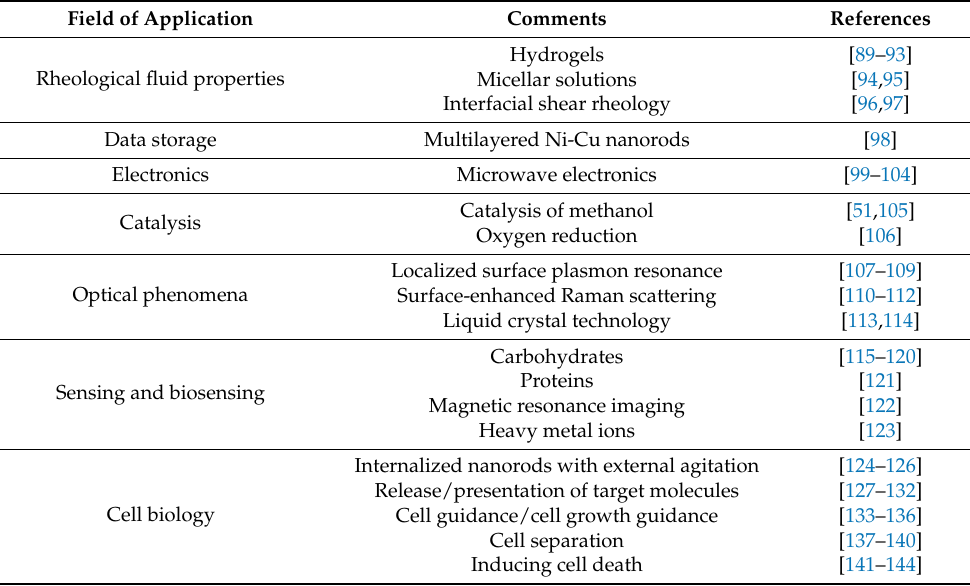
Table 1. Summary of Ni nanorod